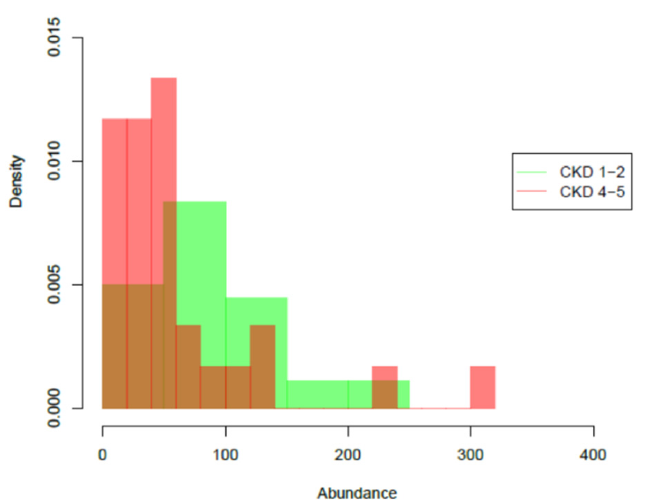
Figure 3. Significant differences of the abundance of Butyricicoccus , a genus with butyrate-generating properties, between earlier (CKD stages 1–2; green) and later (CKD stages 4–5; pink) stages of CKD. Brown: the intersection of both graphs. p =